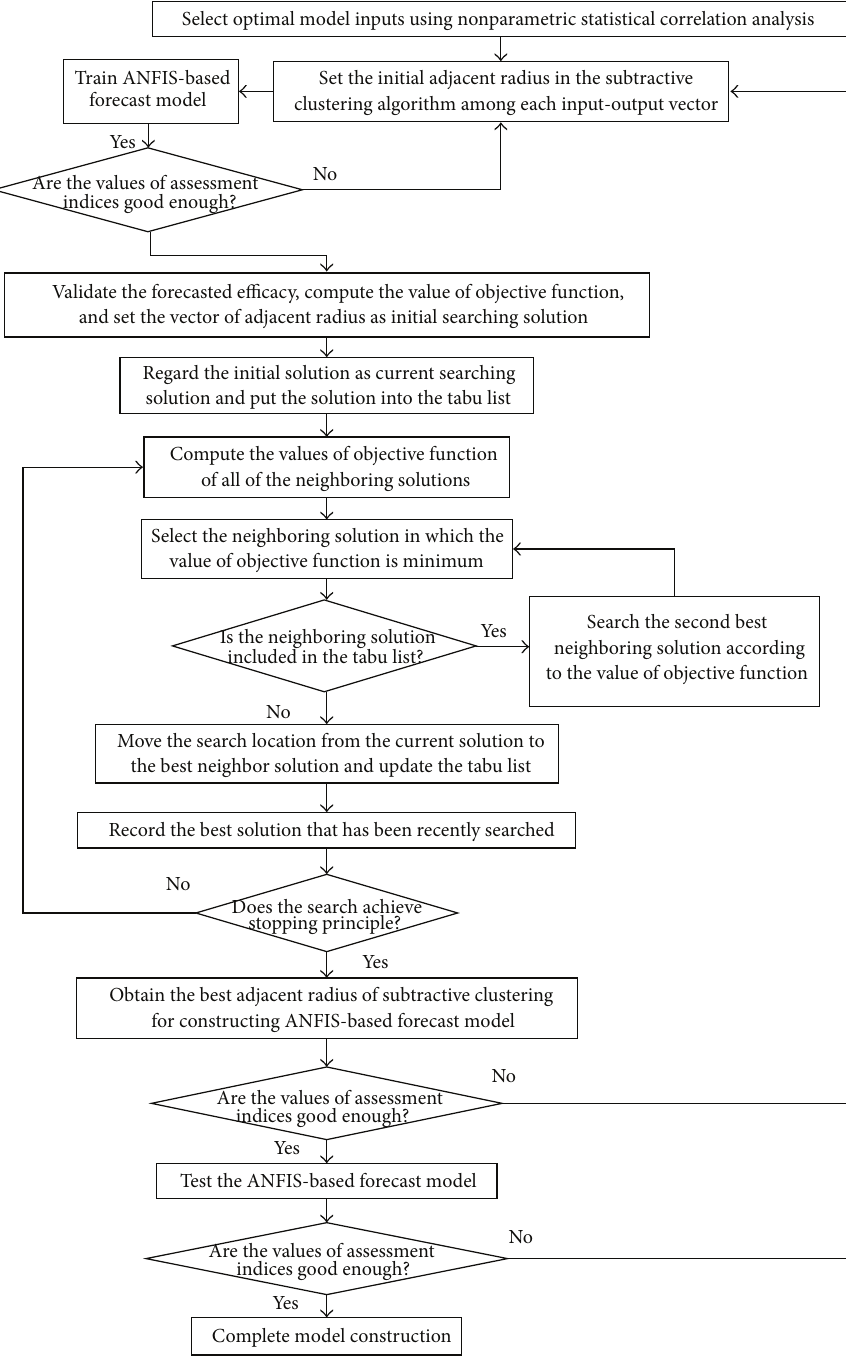
Figure 2: Flowchart of the developed methodology for determining the optimal parameter and structure of